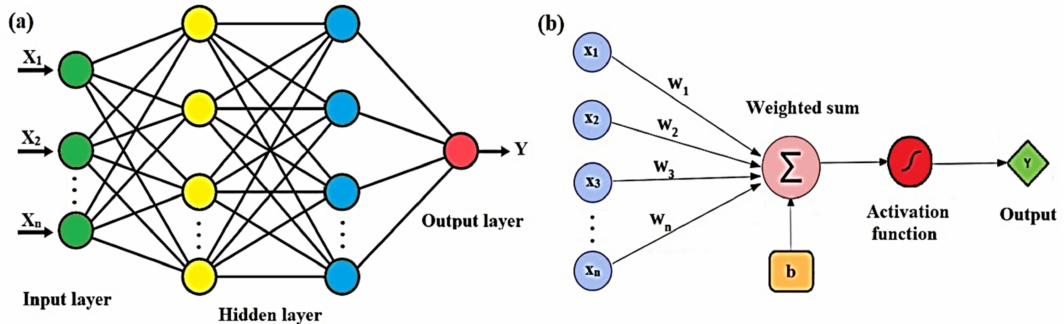
Figure 4. ( a ) The schematic of a three-layer NN; ( b ) signal-flow graph of a